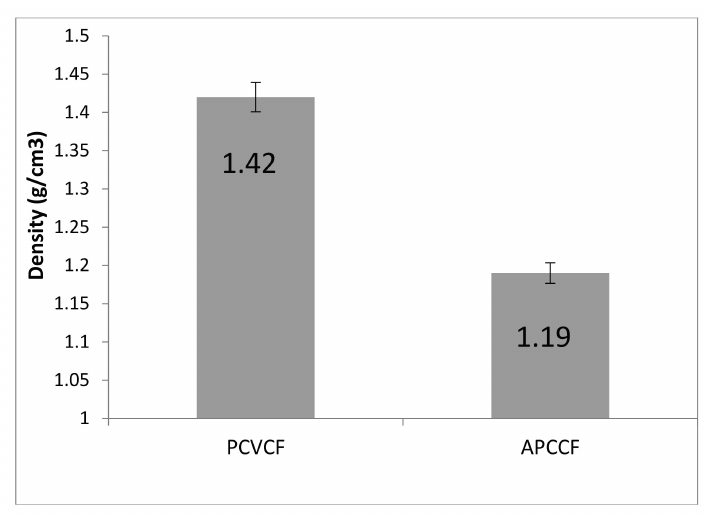
Figure 4. The comparative density of the PVCCF and APCCF. PVCCF is composed of two main ingredients: PVC and polyester which both are heavier in volume/mass unit than that of polyamide—the sole component of the APCCF, resulting in a lighter